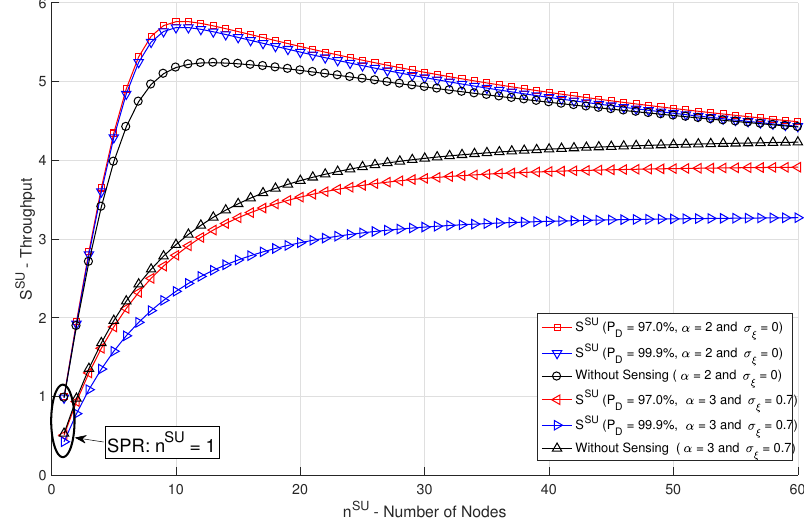
Figure 5. Conditional throughput ( S SU ) achieved by SU versus n SU , for P D = { 97.0%,99.9% } nodes, α = { 2,3 } and σ ξ = { 0,0.7 } . The SPR case is highlighted in the figure with the rectangle “ SPR : n SU =